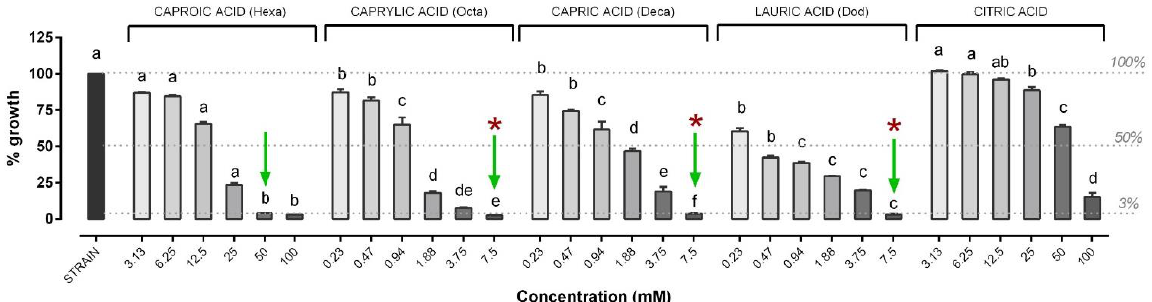
Figure 5. Growth of V. harveyi strain after 24 h of incubation with the different OA. V. harveyi growth is expressed as a percentage relative to control (strain) and values are presented as the mean ± SEM ( n = 3). Data within each OA were analyzed with one-way ANOVA (including the strain value) and columns with different letters were significantly different ( p ≤ 0.05). Concentrations of each compound are reported in the X axis, while the percentage of growth in the Y axis is reported compared to control. The dashed lines indicate (from top to bottom): control strain level (set as 100% of growth), 50% of growth compared to control (possible OA concentrations able to inhibit 50% bacteria) and the level below which the doses of OA were considered to inhibit bacterial growth (3%). Green arrows indicate MIC while red asterisks indicate 5 mM or ≥100 mM). The MBC was defined only for those compounds that showed an MIC value among the tested concentrations.